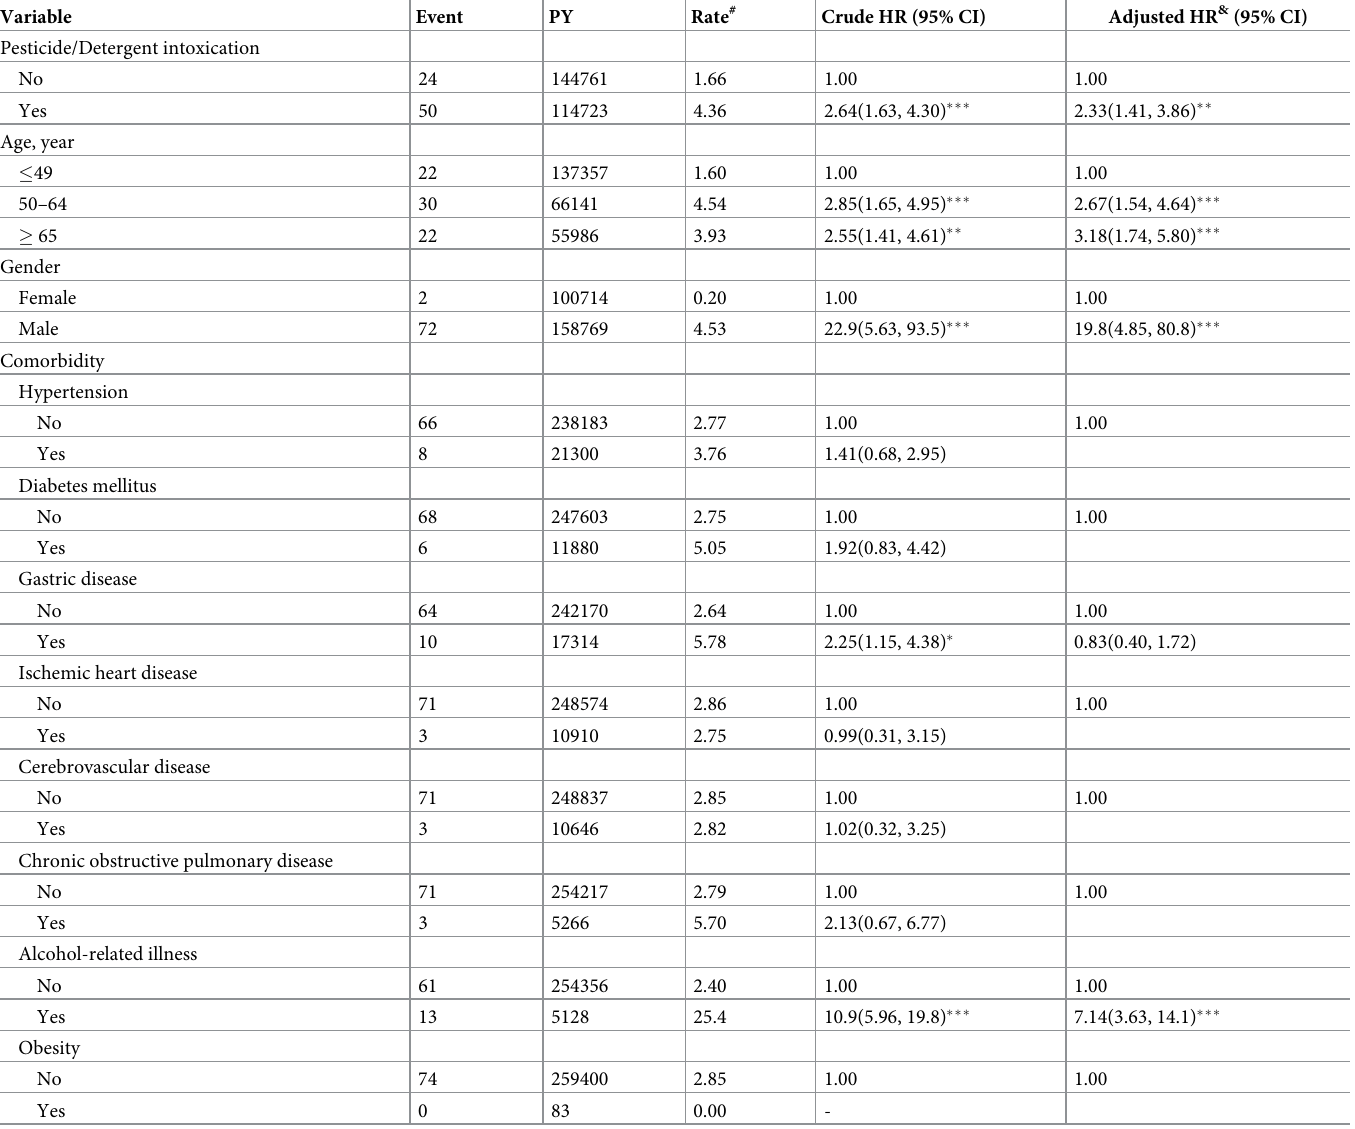
Table 2. Incidence per 10,000 person-years of and risk factors for esophagus cancer.